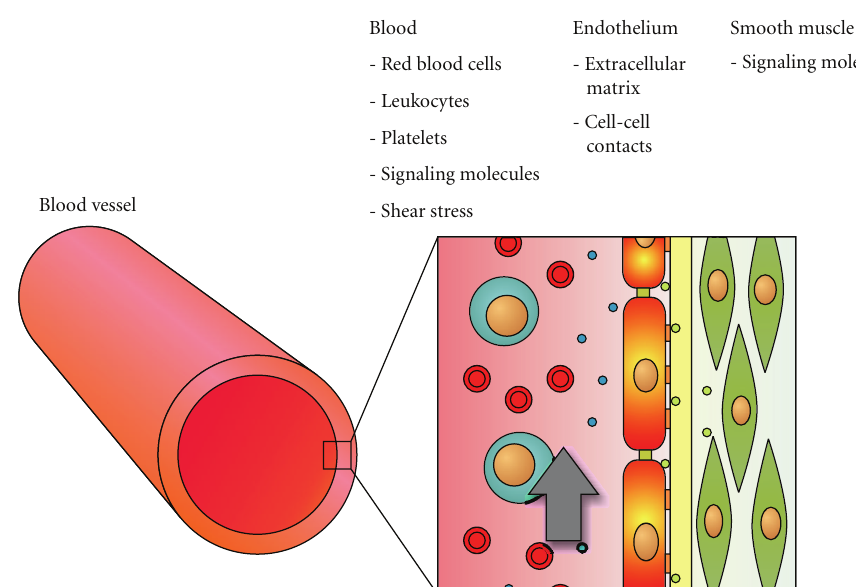
Figure 1: Schematic overview of a blood vessel and the endothelial cell microenvironment. The inner wall of a blood vessel (left) consists of a layer of endothelial cells that are embedded in a three-dimensional microenvironment (right). This environment consists of cell biological, biochemical, and physical stimuli, such as red and white blood cells, signaling molecules, and shear stress, respectively. Mimicking this complex microenvironment in vitro is a major challenge in vascular research.